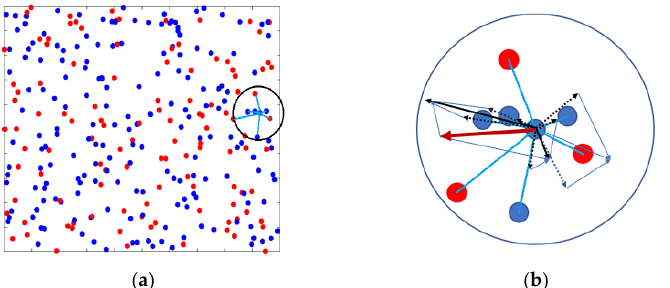
Figure 1. ( a ) Schematic diagram of node neighbors on the two-dimensional plane; ( b ) schematic diagram of the migration direction. In Figure 1, the red circles represent defectors and the blue circles represent cooper- ators. The red arrow represents the direction of movement of the central individual.